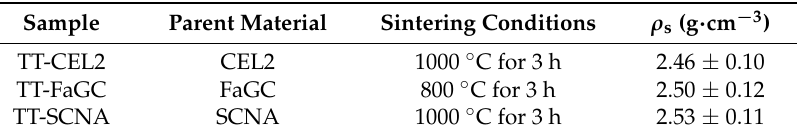
Table 2. Sintered glass-ceramic samples: preparation details and resulting